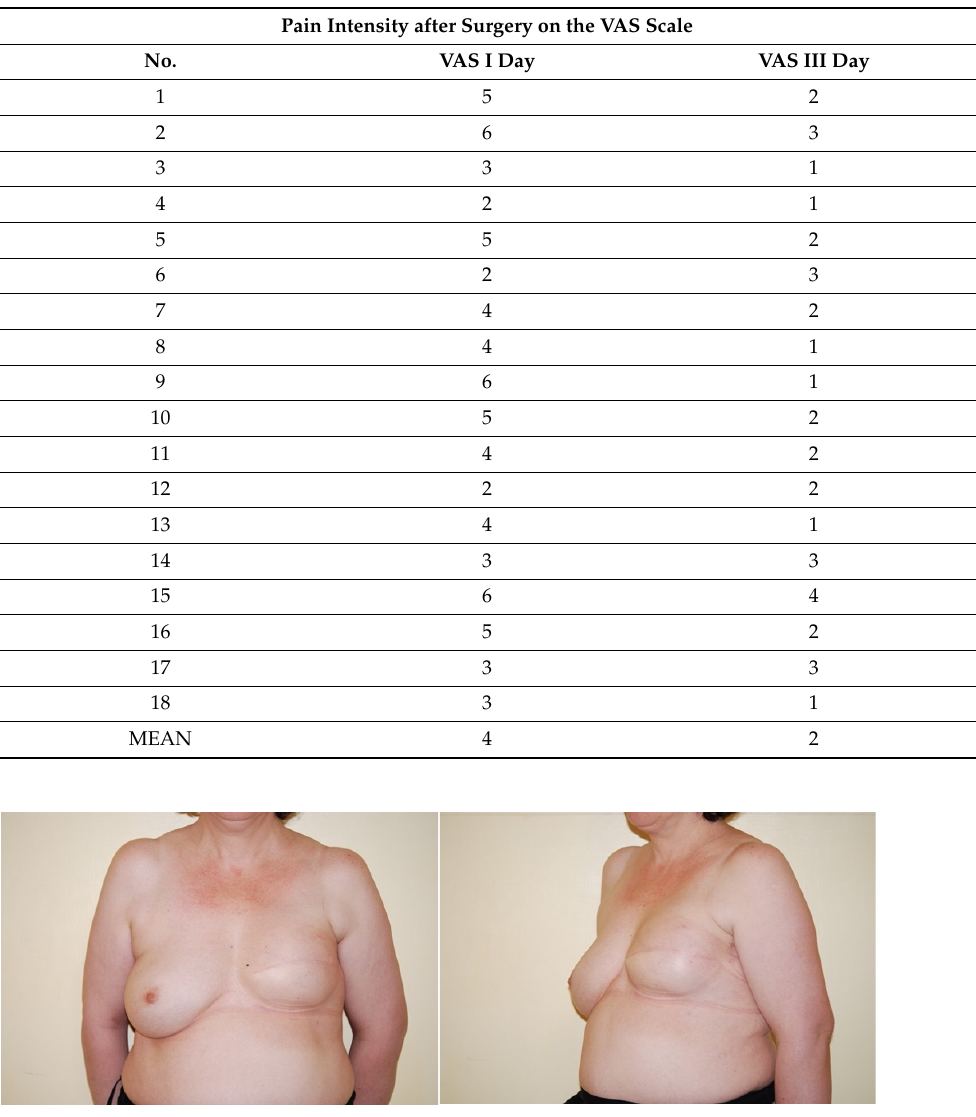
Figure 3. Six months post-op. Patient undergoing mastectomy and breast reconstruction with breast expander.